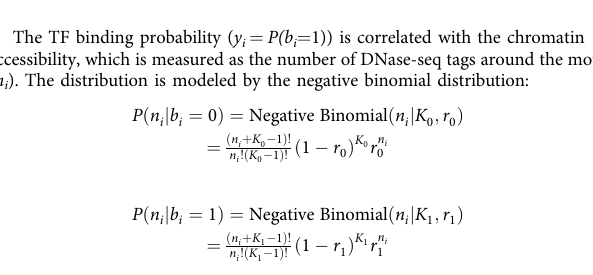
Fig. 3b. The contribution of PWM score ( f i ), distance to TSS ( d i ) and conservation levels ( c